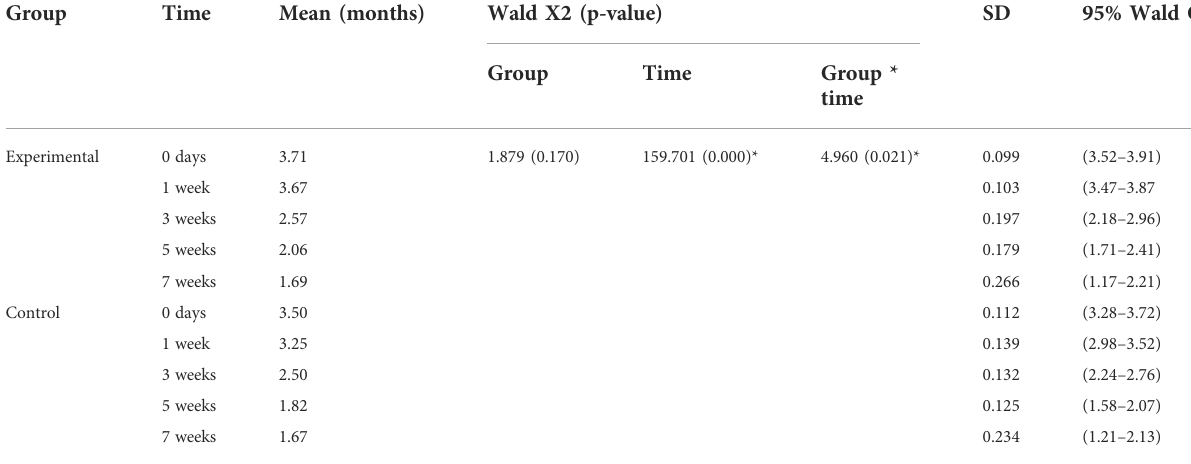
TABLE 4 Statistical analysis of periodic changes in wound depth grade in the two groups.